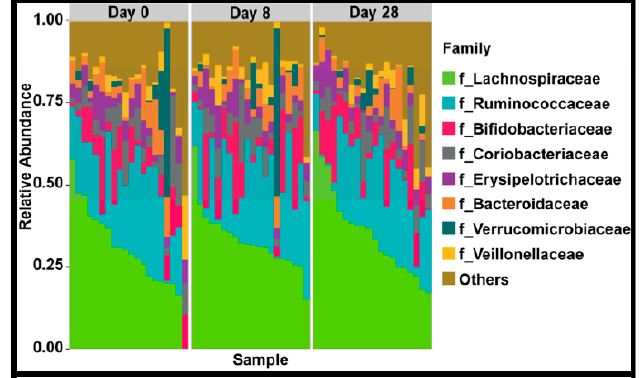
Figure 4. Plots showing the most abundant taxa at the family level as proportional abundances in the three groups (Day 0, 8, 28). three groups (Day 0, 8, 28).